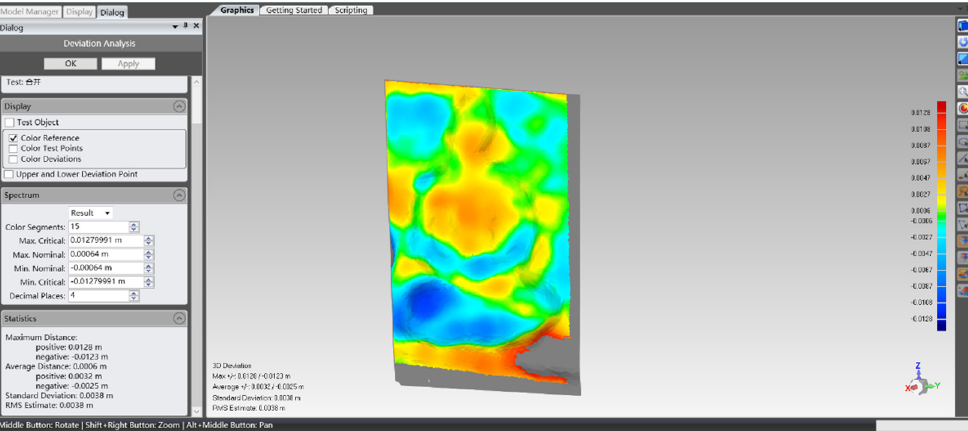
Figure 12. Three-dimensional (3D) model deviation analysis of Buddhist statues No. 2 and